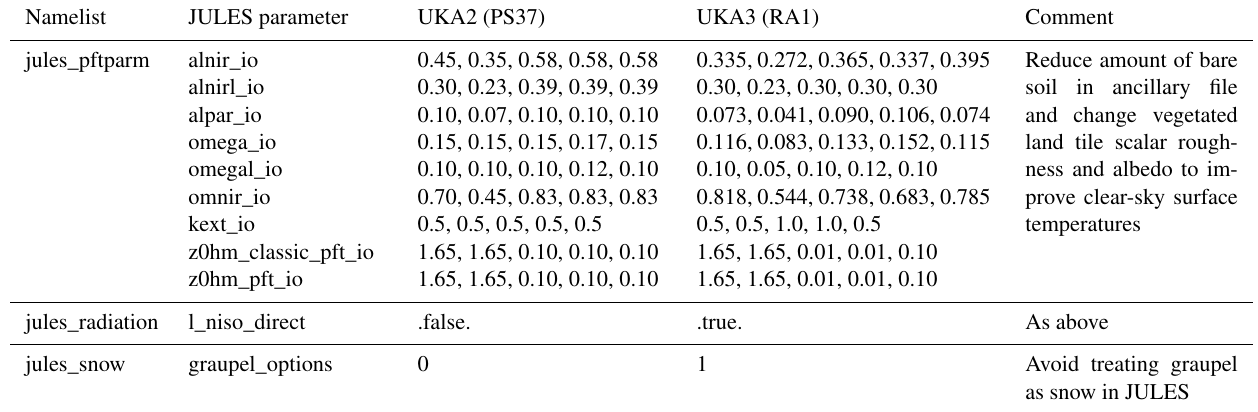
Table 7. Summary of key changes between UKA2 and UKA3 configuration JULES namelists, associated with implementing enhanced science options based on regional atmosphere-only model development and evaluation. Registered MetUM users can access further details at https://code.metoffice.gov.uk/trac/rmed/wiki/ra1/protoRA1 (last access: 18 February